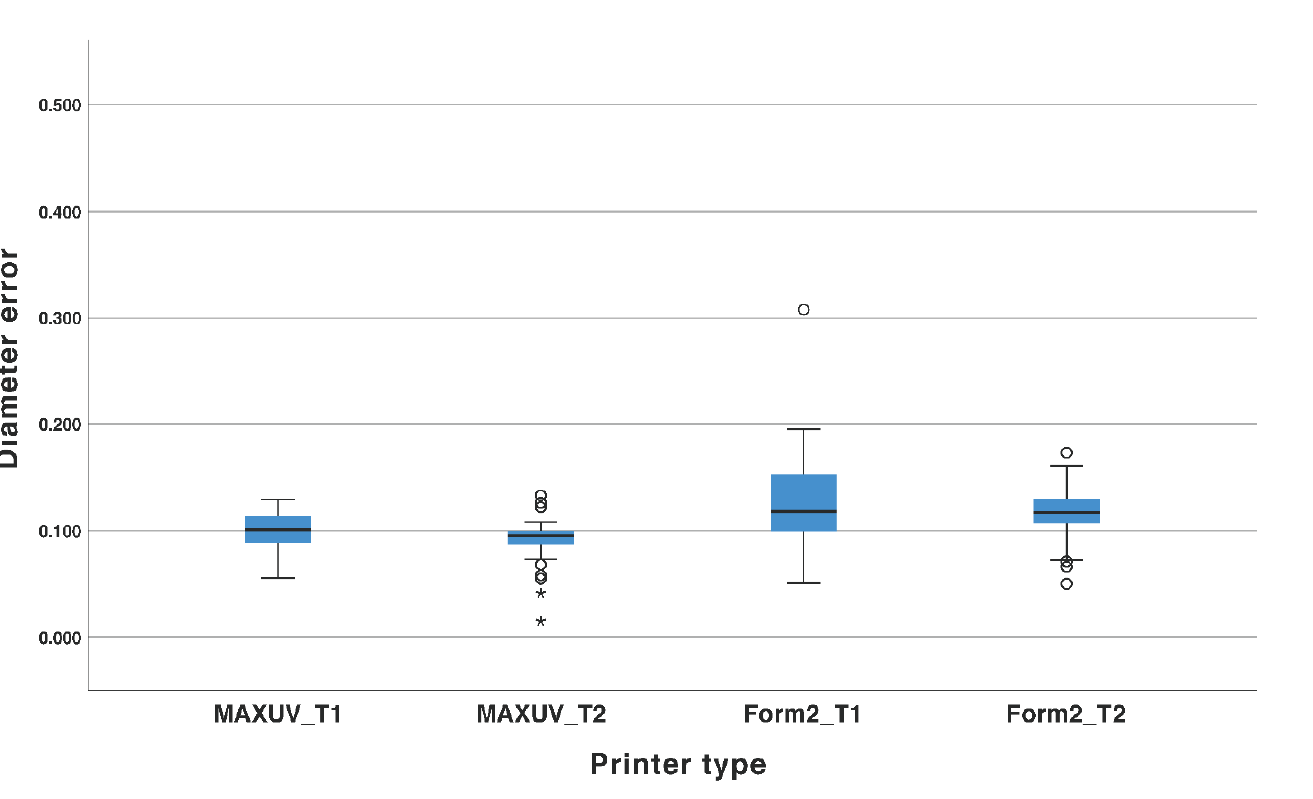
Figure 2. Boxplot for the median error and precision of the sphere diameter at T1 and T2 for MAX UV and Form 2 3D printed models. o Denotes outliers more than 1.5 IQR but less than three IQR from the end of the boxplot. * Denotes outliers more than three IQR from the end of the boxplot.